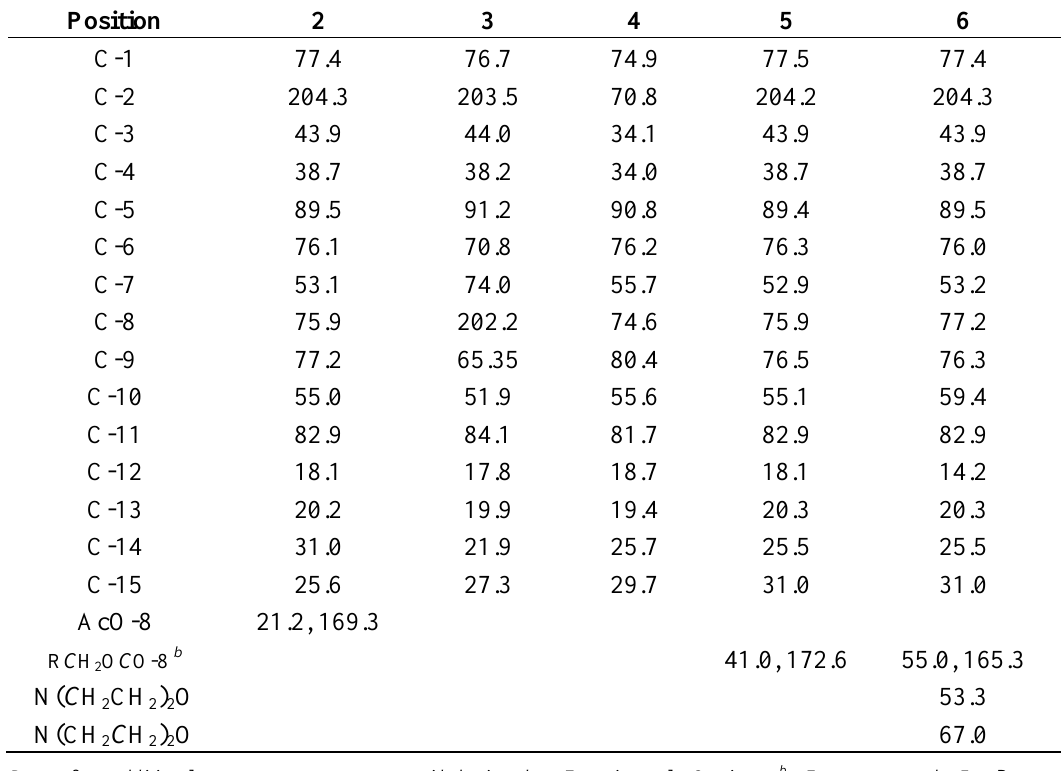
Table 2. 13 C NMR Spectroscopic data of compound 2–6 (500 MHz, CDCl